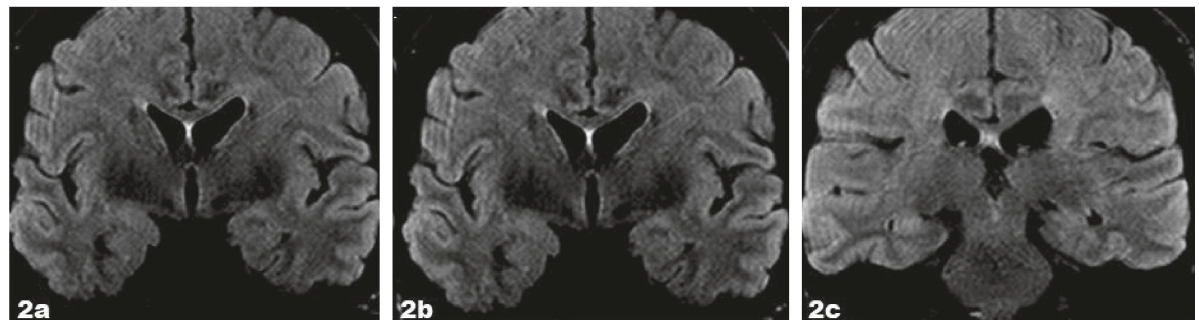
Figure 2: (a–c) Coronal FLAIR-MRI scan after treatment, four weeks later, was Table 2: Neurological complication seen after allogeneic hematopoietic stem cell transplantation.